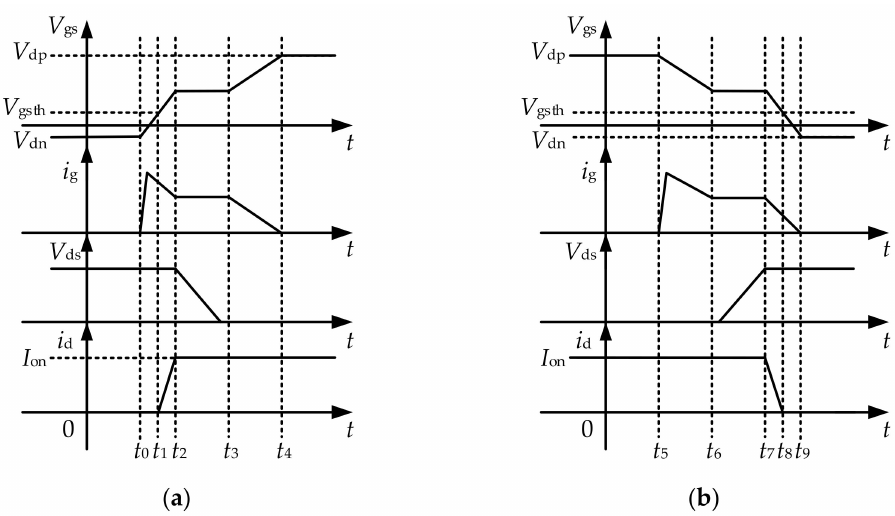
Figure 5. The simplified waveforms change during SiC MOSFET switching: ( a ) Turn-on process, ( b ) Turn-o ff